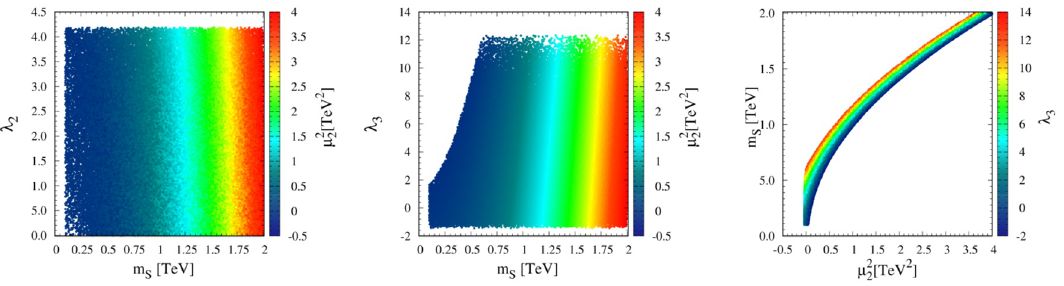
Figure 2 . Allowed parameter space in the degenerate IHDM spectra are shown, where the various theoretical constraints and experimental bounds from the DS and EWPT are taken into account: a) ( λ ) plane with µ 2 colored on the vertical axis; b) ( λ ) plane with µ 2 colored on the 2 , m S 3 , m S 2 2 vertical axis and c) ( m ) plane with λ colored on the vertical 2 S , µ 3 2